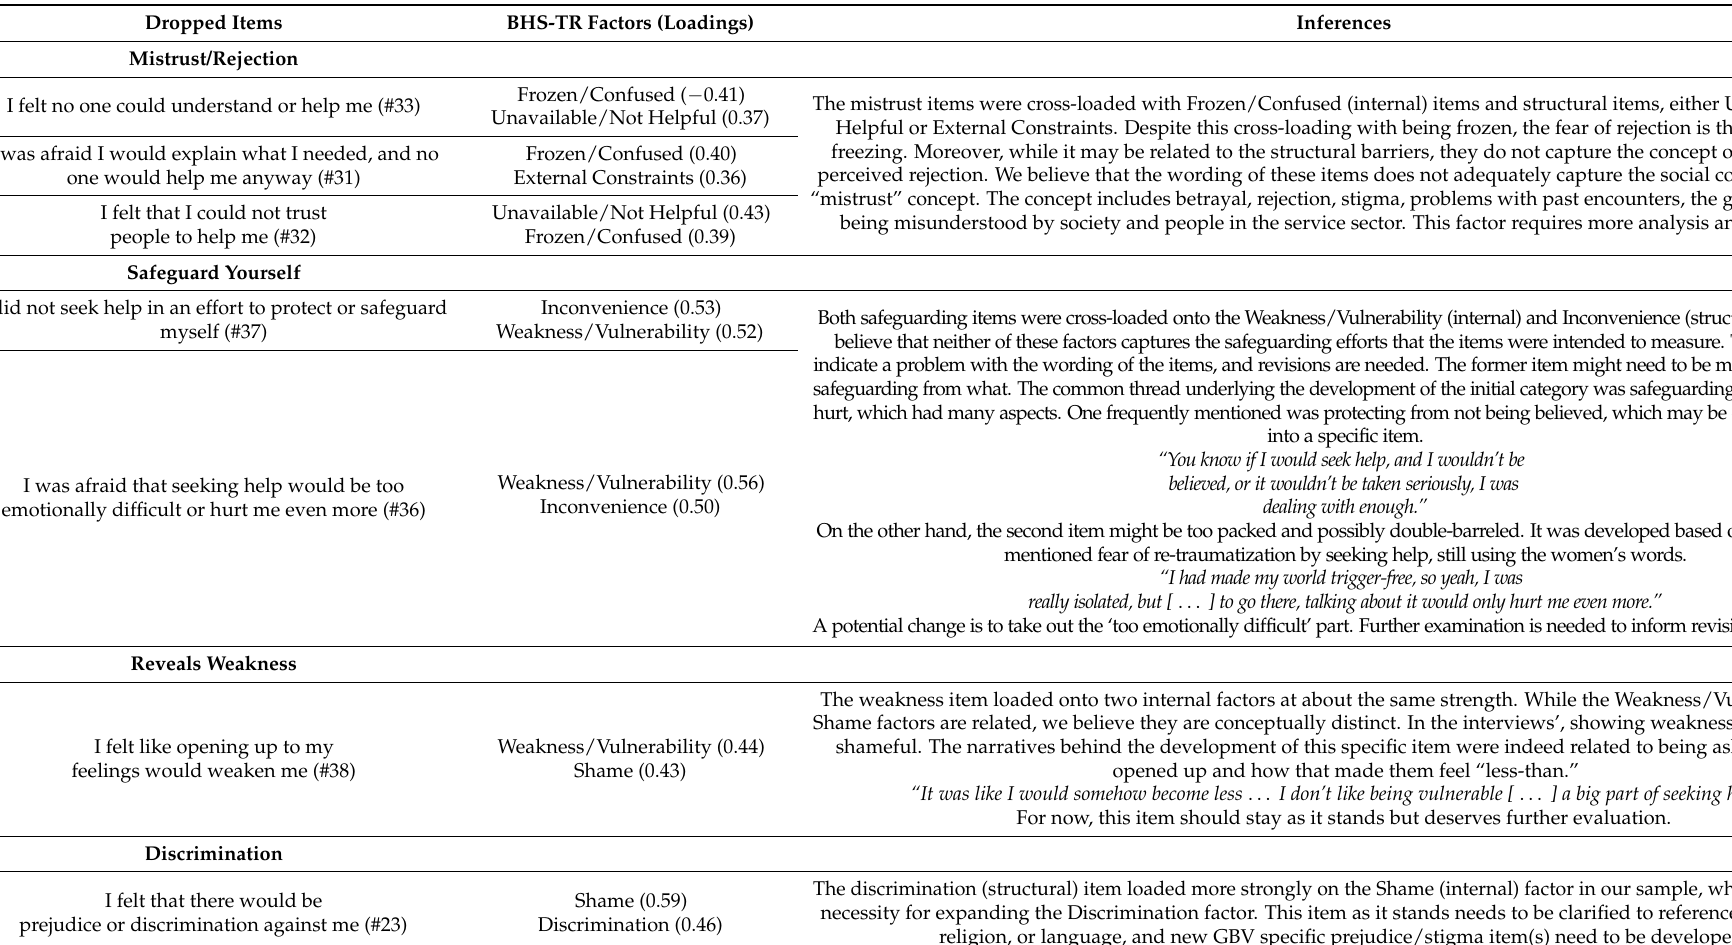
Table 5. Cross-loadings of the dropped